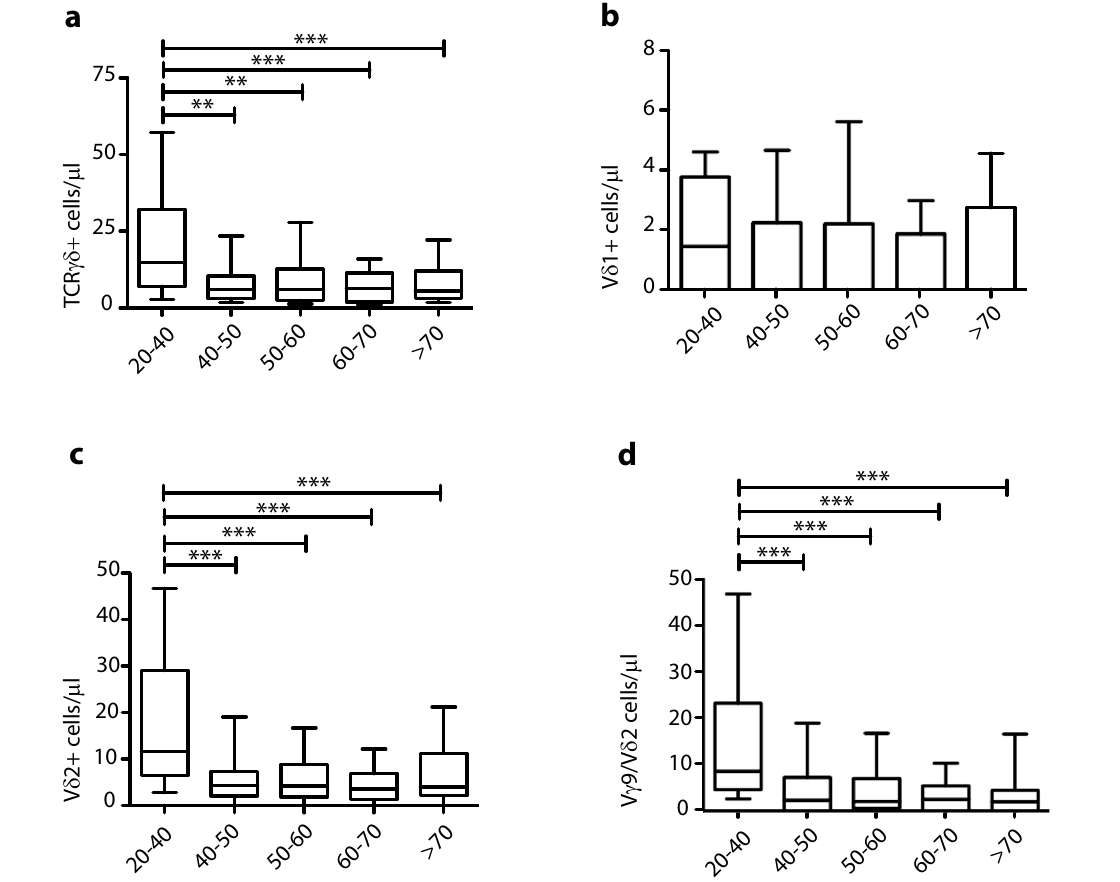
Figure 1. V γ /V δ -gene usage in TCR γδ+ T-cells in different age groups. ( a ) Absolute numbers of total TCR γδ+ T-cells, ( b ) V δ 1 + , ( c ) V δ 2 + and ( d ) V γ 9/V δ 2 TCR γδ+ T-cells depicted as 10–90%